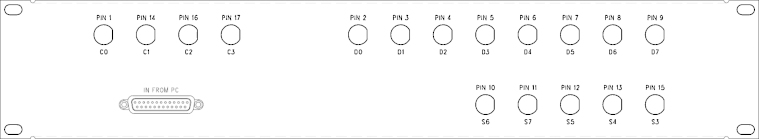
Schematic example of “patch panel” input/output pin layout suitable for the computer-parallel port interface.